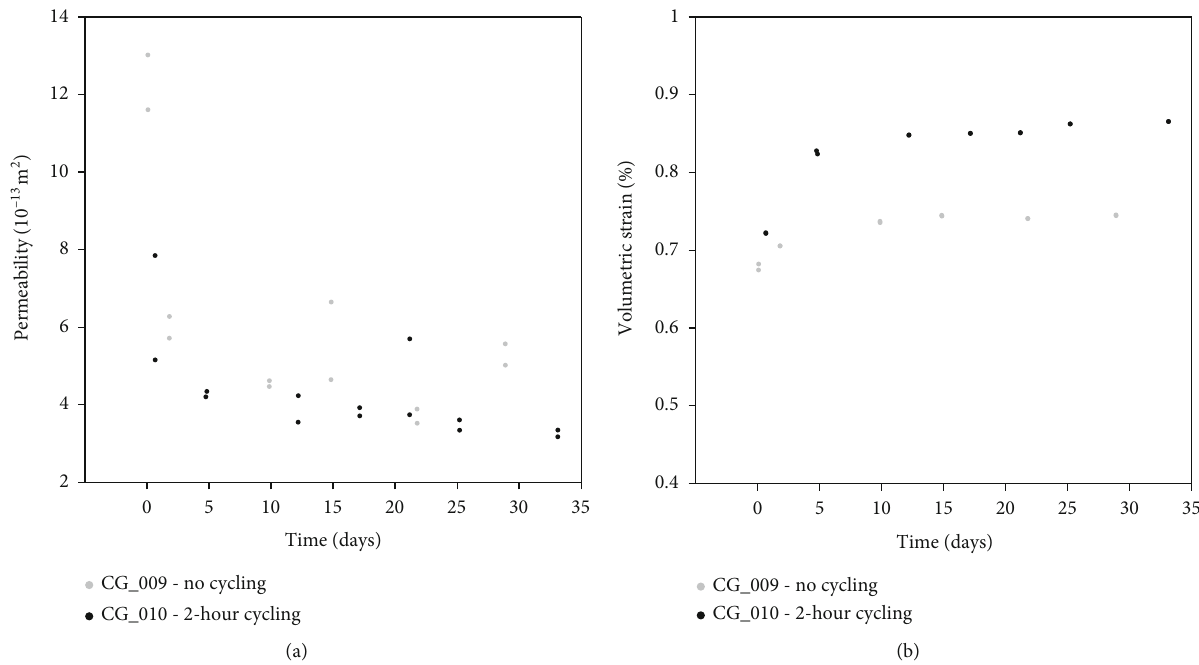
Figure 11: Permeability (a) and volumetric strain (b) measurements compared with time